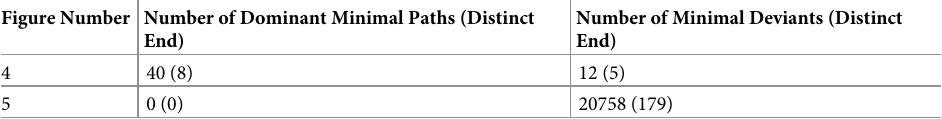
Table 2. Summary of simulation output related to paths arising from initial landscapes shown in Figs 4A and 5A that led to viable candidates. Figure Number Number of Dominant Minimal Paths (Distinct